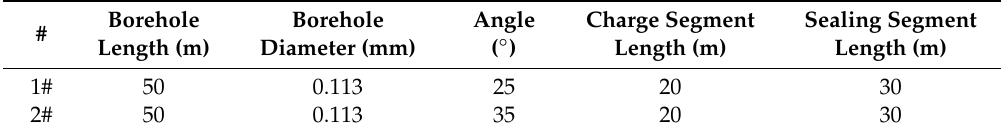
Table 5. Borehole parameters for the deep blasting hole.